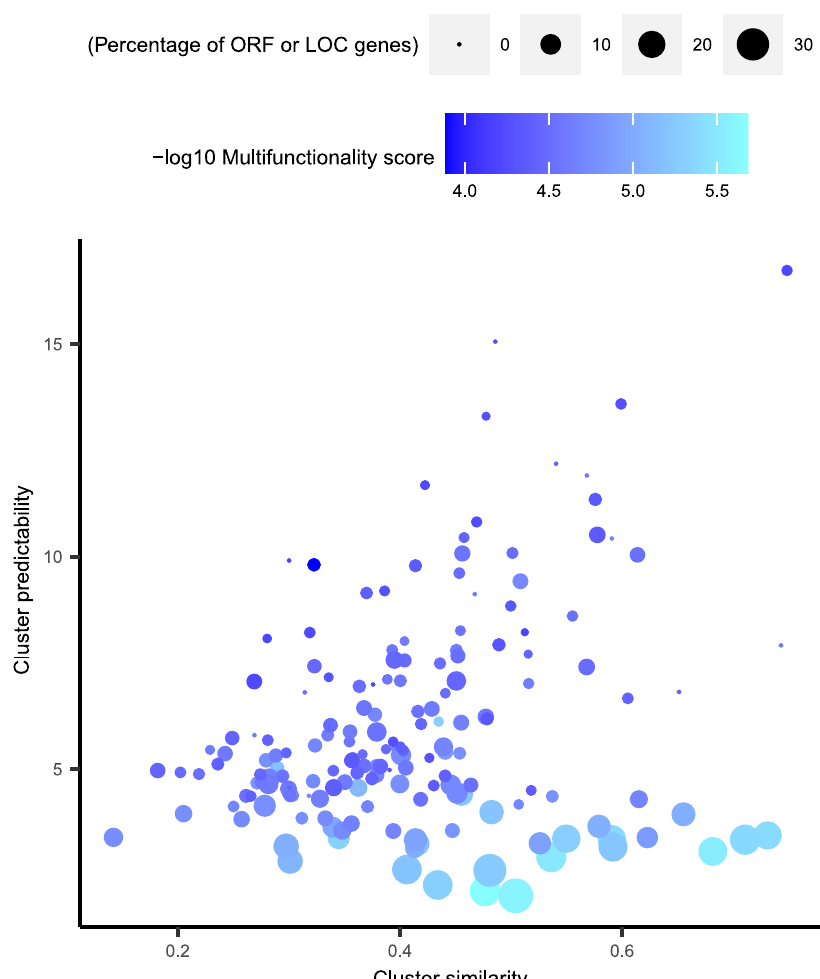
Fig. 5 Relationship between the degree of transcriptional similarity and predictability among clusters of co-regulated genes. Scatterplot of cluster transcriptional barcode similarity ( x -axis) and cluster predictability score ( y -axis) for cluster groups ( n = 173). The cluster transcriptional similarity is de fi ned as the median pairwise distance between every gene in the cluster as de fi ned in the distance correlation matrix. A median of the maximum prediction score of each gene in the cluster was calculated to represent the cluster predictability score. Multifunctionality is depicted with a gradient from high (dark blue) to low (cyan). Clusters with high similarity but low predictability scores are composed of more uncharacterized genes (ORFs and LOCs) than other clusters. In addition, the multifunctionality scores of the genes belonging to these clusters are low (cyan), re fl ecting low frequency of gene set